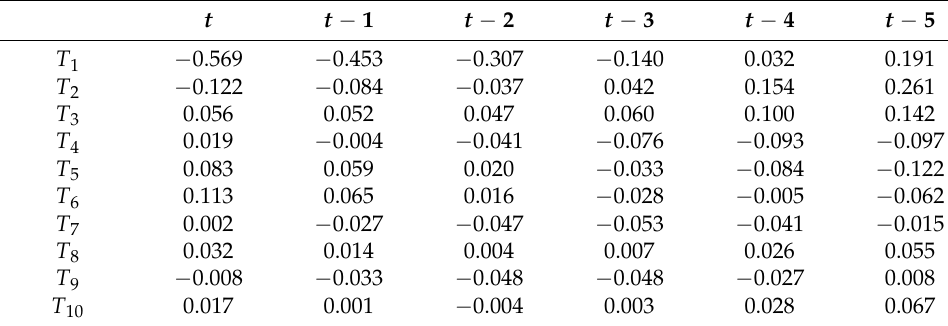
Table A2. Model parameters for bottom